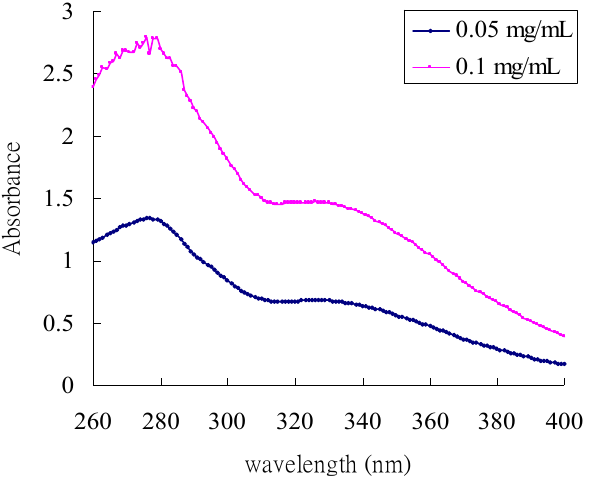
Figure 1. UV absorption spectrum (260–400 nm) of Artocarpus communis methanol